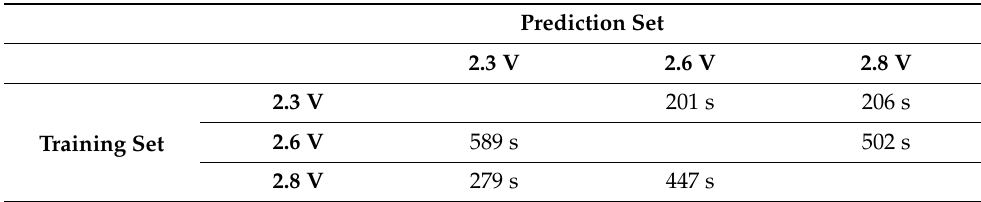
Figure 15. Scatter plot comparing the predictions of the ANN trained on surface temperatures with experimental data for test data set of 2.8 V (training data set of 2.6 V). Table 4. Average absolute error in the final 1800 s (prior to attaining a melt-fraction of 85%) for different training/prediction data-set combinations using transient surface-temperature data.